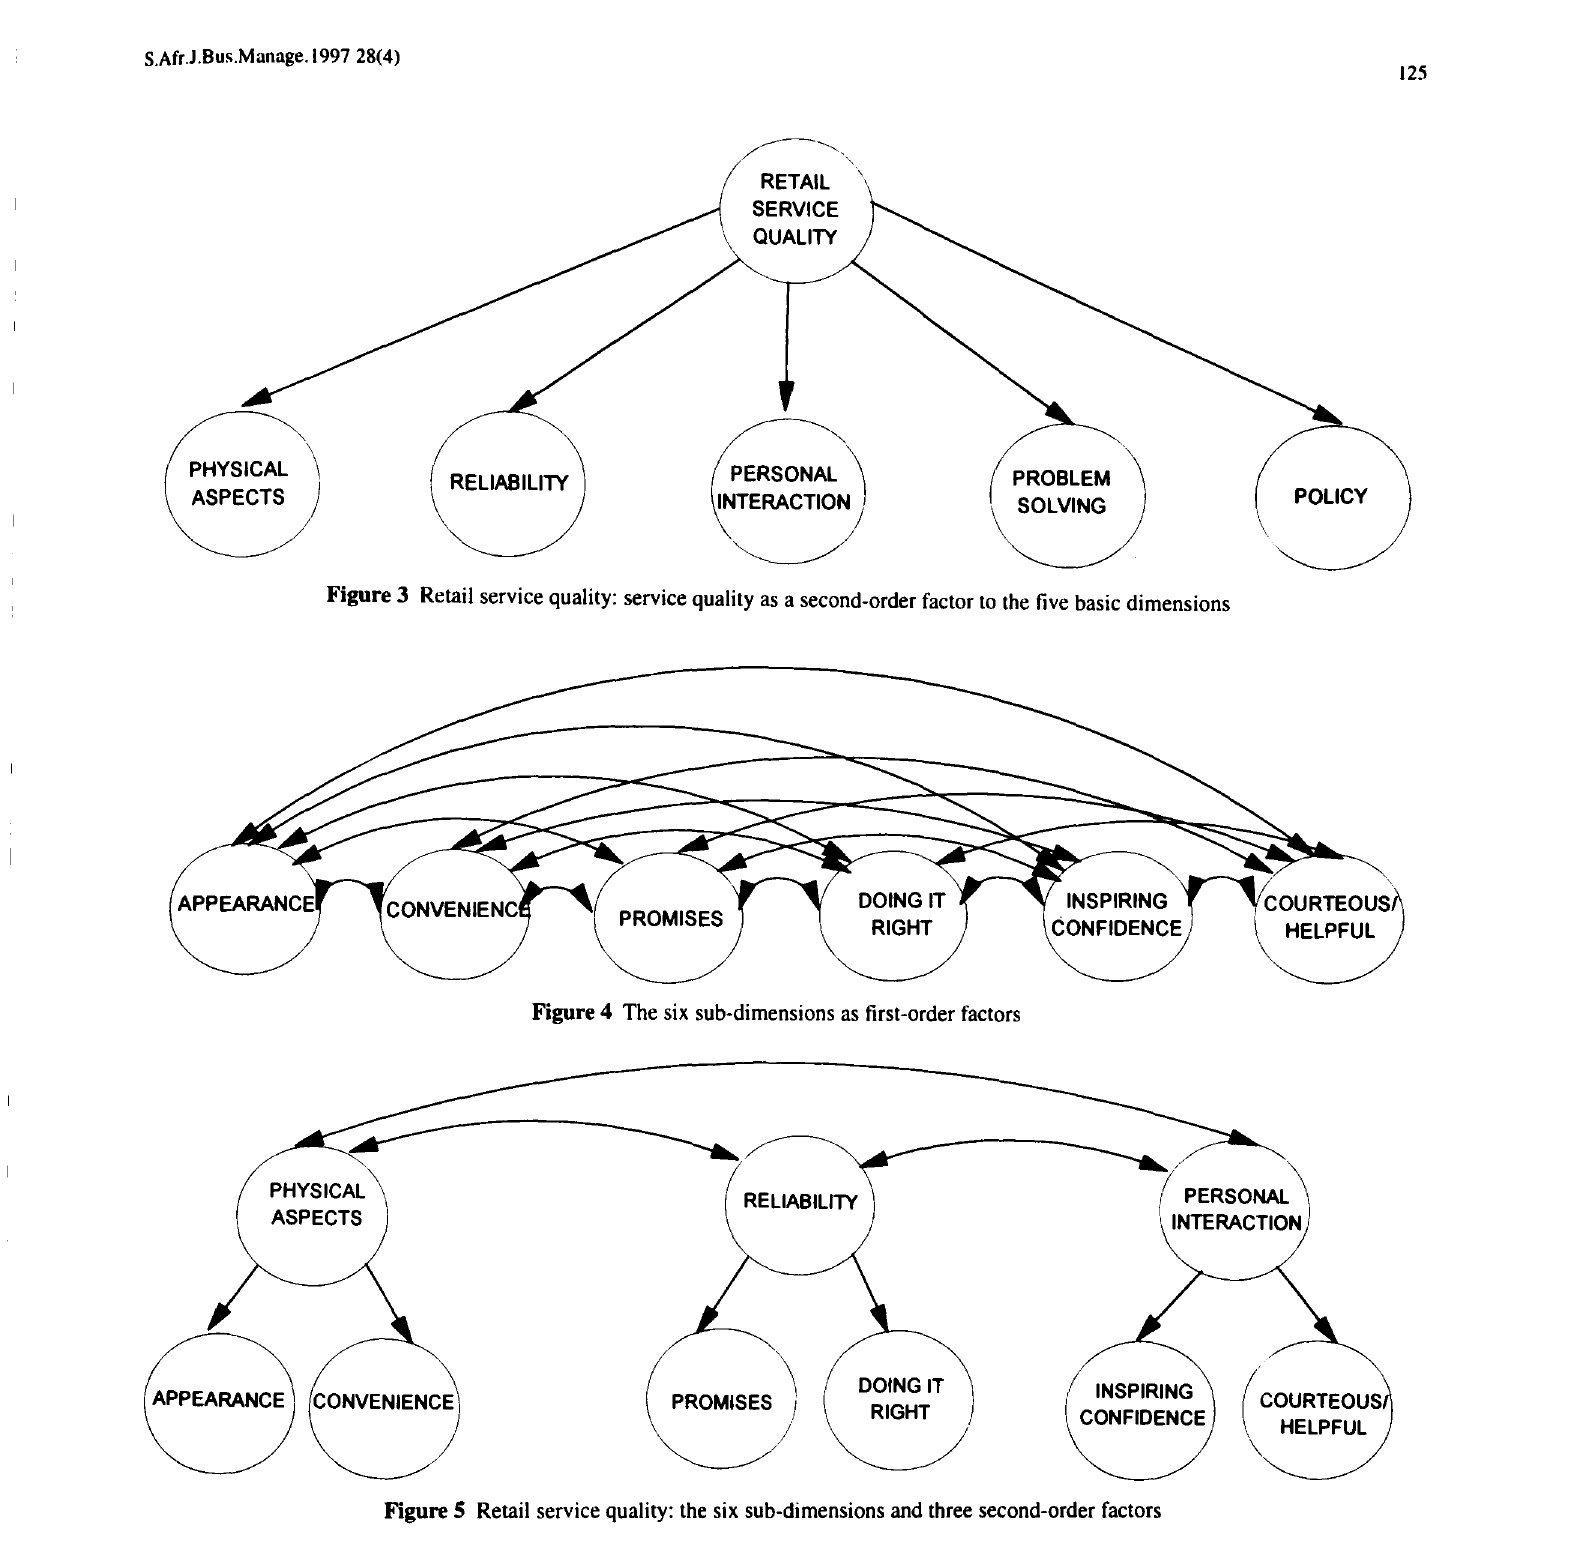
Figure 5 Retail service quality: the six sub-dimensions and three second-order factors Empirical results